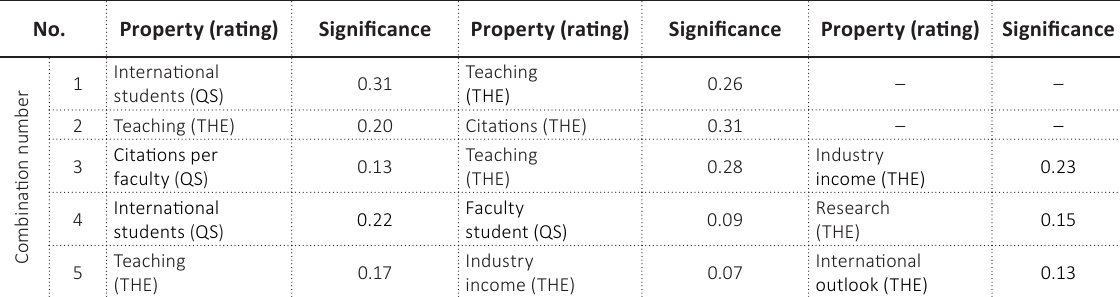
Table 4. Combinations of criteria with 100% discriminating ability, with each of them belonging to the rankings and an assessment of individual significance, 2020